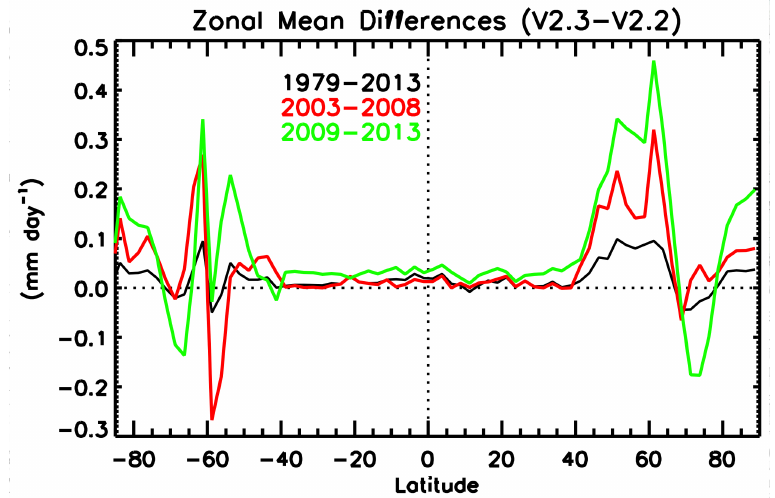
Figure 4. Differences in zonal mean profiles of GPCP oceanic precipitation (V2.3–V2.2) for the three time periods discussed in the text.